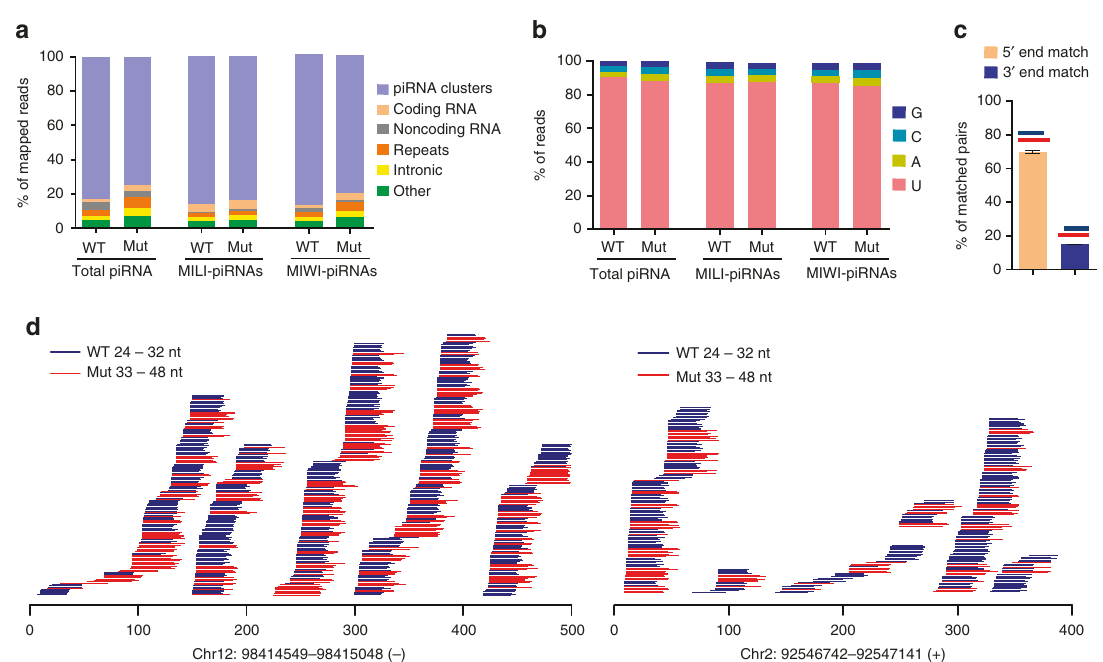
Fig. 5 piRNA 3 ′ end extension in adult Pnldc1 Mut testes. a Genomic annotation of total piRNA, MILI-piRNAs, and MIWI-piRNAs from adult WT and Pnldc1 Mut (Mut-1) testes. Sequence reads (24 – 48 nt) from small RNA libraries were aligned to mouse sequence sets in the following order: piRNA clusters, coding RNA, non-coding RNA, repeats, and intronic sequences (see Methods for details). “ Other ” represents sequence reads that did not mapped to the above fi ve sequence sets. The percentage of mapped reads is shown. b Nucleotide distributions at the fi rst position in total piRNA, 3 ′ ends in Pnldc1 Mut testes. The 33 – 40 nt reads from Pnldc1 Mut (Mut-1 and Mut-2) total piRNA library were mapped to 24 – 32 nt reads from WT total